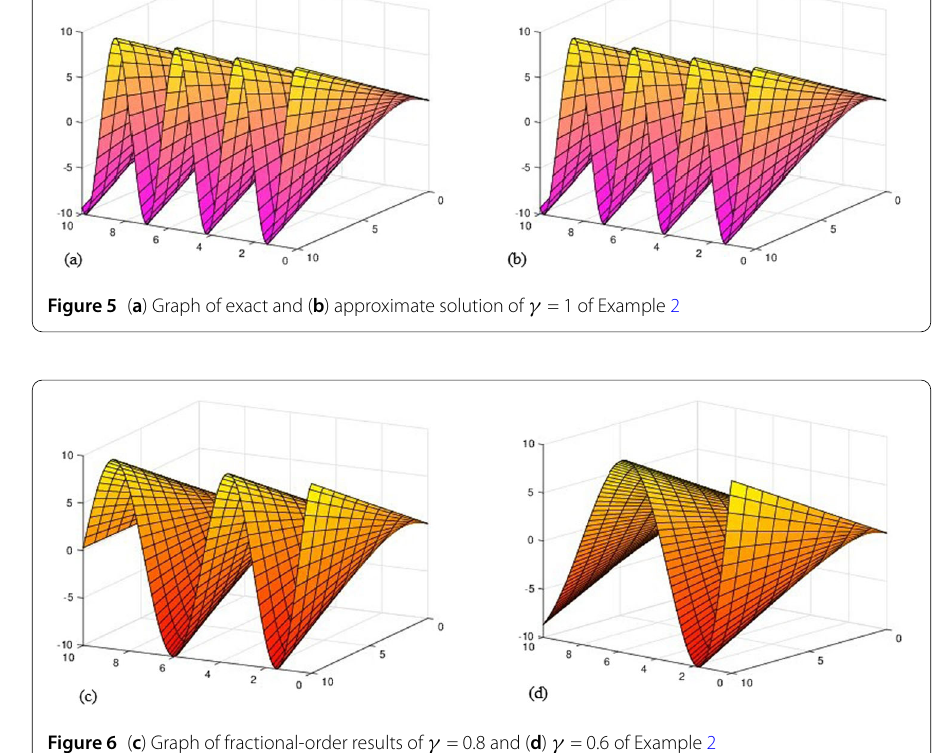
Figure 6 ( c ) Graph of fractional-order results of γ = 0.8 and ( d ) γ = 0.6 of Example 2